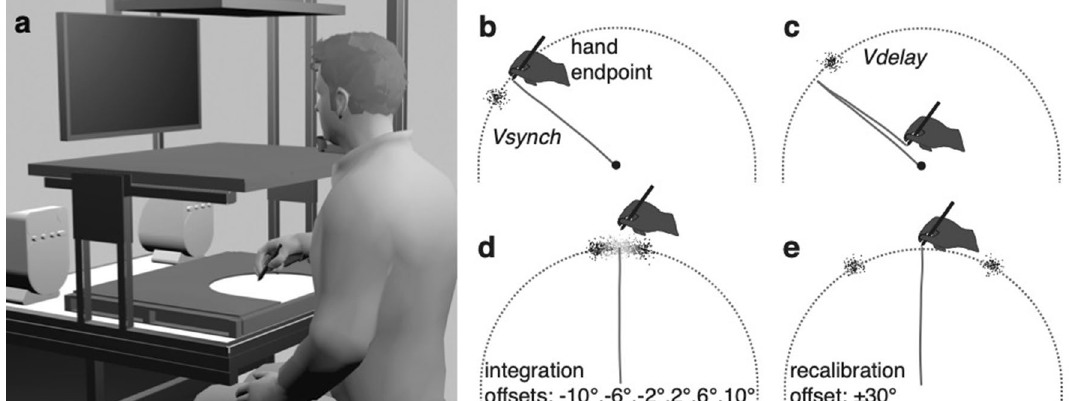
Figure 1. Apparatus, task, and stimuli. ( a ) Participants performed hand movements on a digitizer tablet while visual stimuli were presented on a monitor in front of them. A semi-circular workspace was defined in the horizontal plane by a physical boundary, and in the frontal plane by an invisible semi-circle. In ( b–e ), the two planes are shown on top of each other. ( b ) When the outward-movement ended at the workspace boundary the synchronous visual stimulus was presented ( Vsynch ). Here a visual stimulus with a + 10° angular offset is indicated. ( c ) After the start of the backward-movement towards the workspace’s centre, the delayed